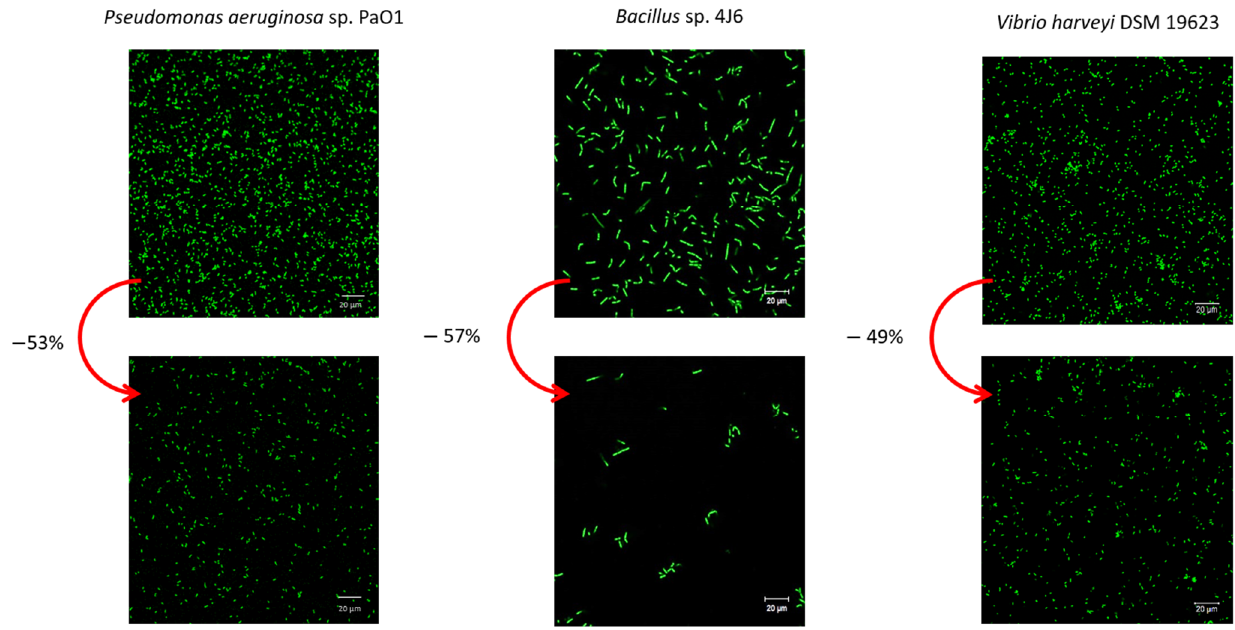
Figure 7. Prevention of bacterial adhesion ( P. aeruginosa , Bacillus sp., and V. harveyi ) with hyaluronan-like EPS in static conditions. Confocal laser scanning microscopy observations of the bacterial adhesion with syto9 ® after 2 h with addition of 125 µ g/mL hyaluronan-like EPS at 20 ◦ C. The biomasses of the biofilms in flow cells were analyzed using COMSTAT software and biofilm percentages (%) were determined compared to the control (Adapted with permission from Ref. [132]. 2022 MDPI ).